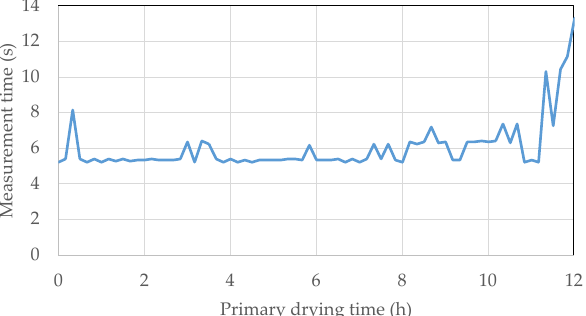
Figure 13. Measurement time for MTM during primary drying for 25 g/L Saccharose, T s — 0°C, and p c — 0.15 mbar.